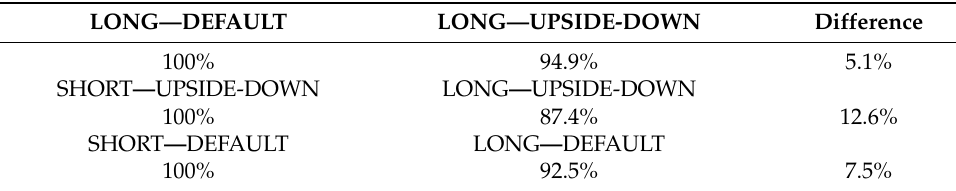
Table 2. Relative comparison of the heat sinks and their position with respect to the difference between heater and ambient temperature. Heat sinks differed in melt entry point. The first one was made with the melt flowing to the longer side of its base (LONG), parallel to the fins and buoyancy; the second one had the entry leading to the shorter side (SHORT), perpendicular to the fins and buoyancy. Both were measured in two space configurations—a reference position (DEFAULT) and turning the heat sink 180 ◦ around its shorter side